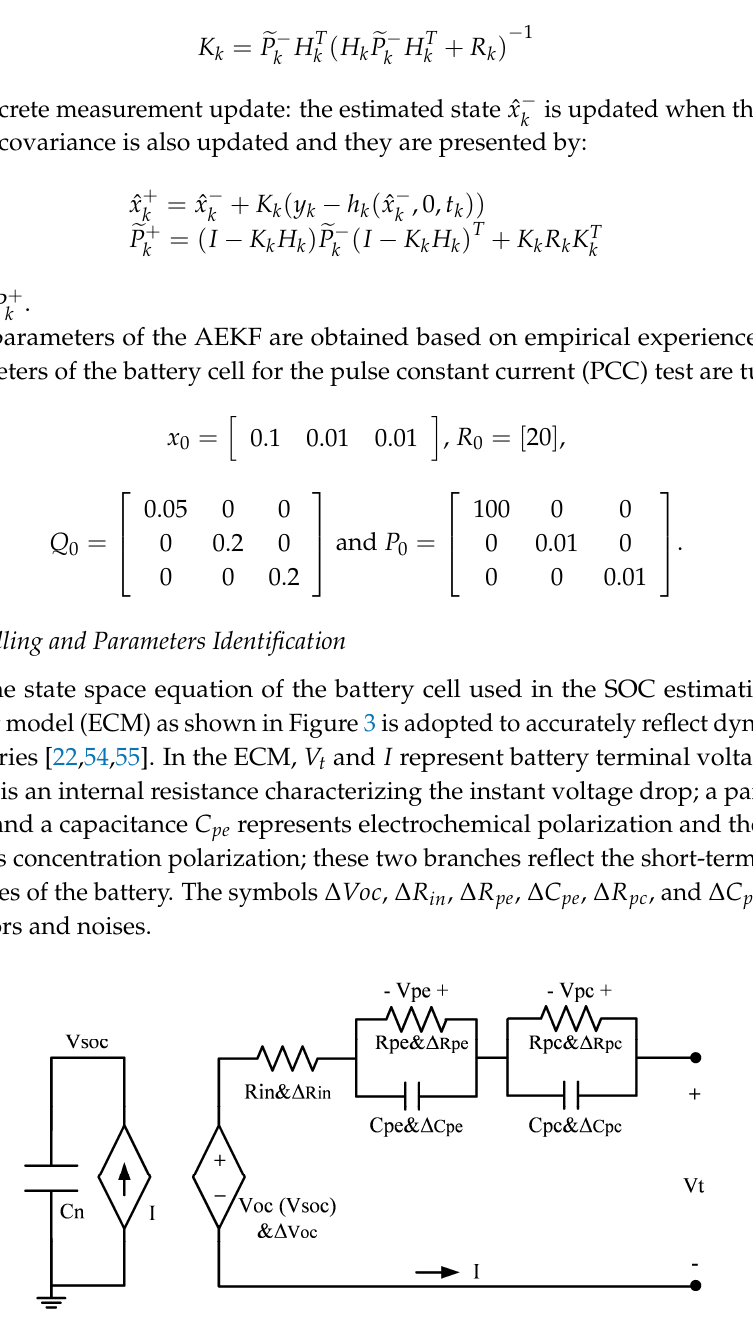
Figure 3. Schematic diagram of battery equivalent circuit model.